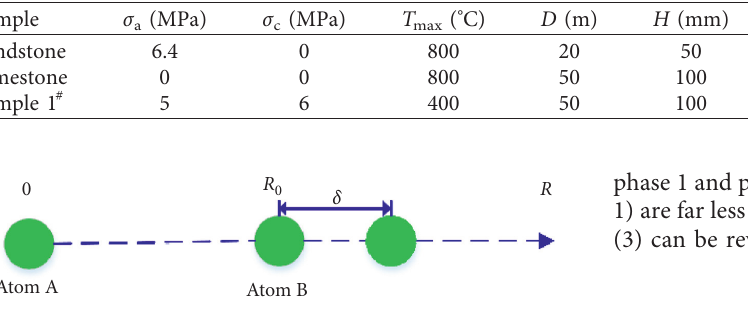
Figure 7: Physical model of thermal expansion of a solid [40].